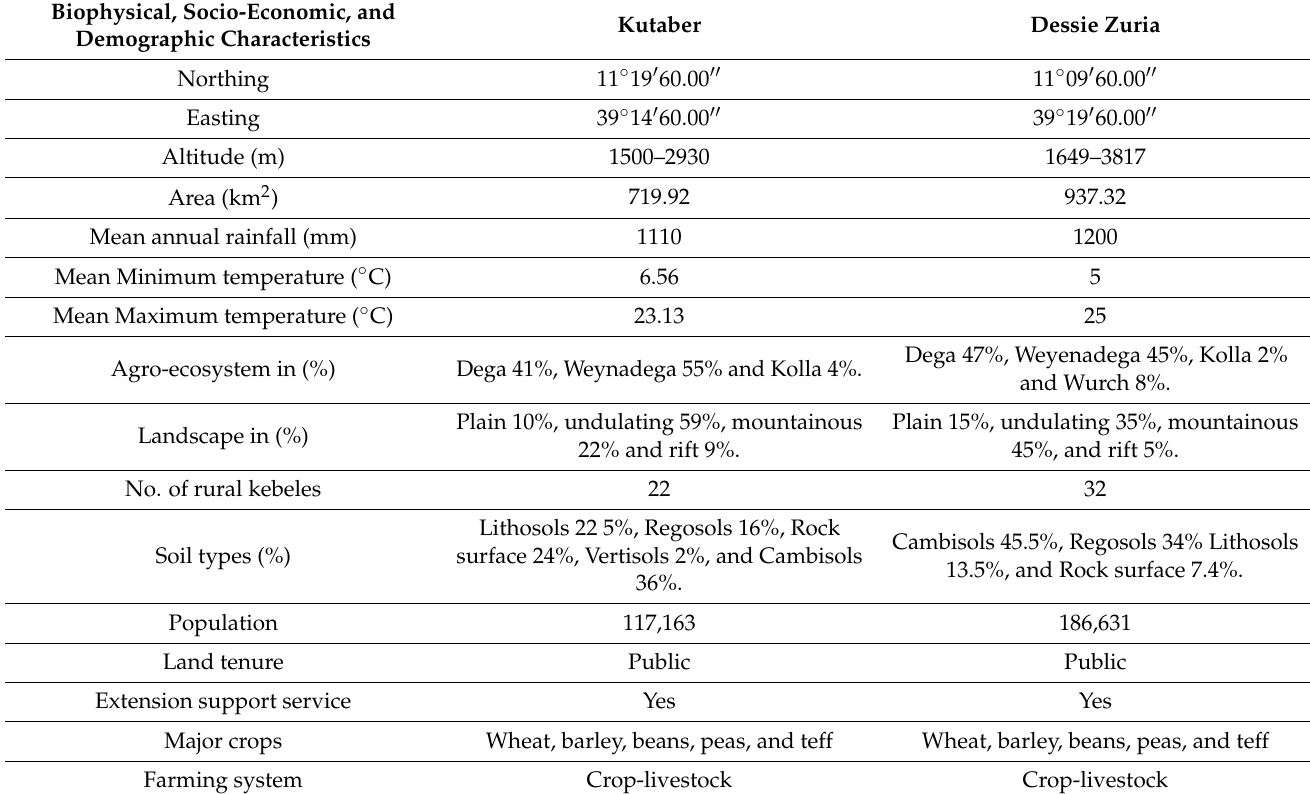
Table 1. Socio-economic and physical features of the study Woredas.